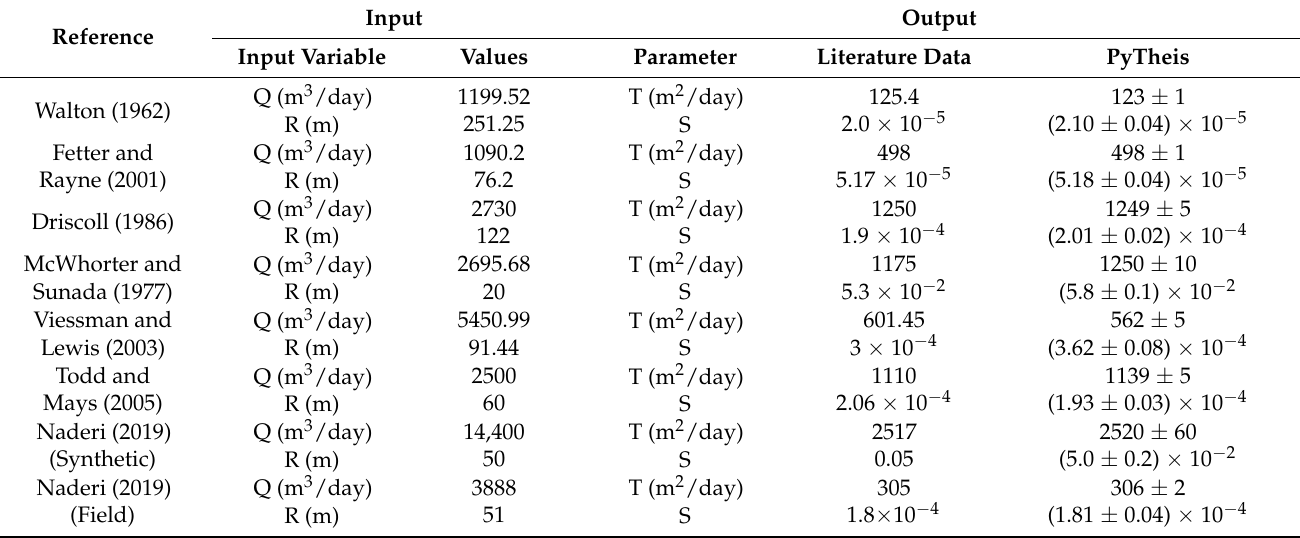
Figure 3. Log–log scale time ‐ drawdown curves fitted using the PyTheis code for the literature problems: ( a ) Walton (1962), ( b ) Fetter and Rayne (2001), ( c ) Driscoll (1986), ( d ) McWhorter and Sunada (1977), ( e ) Viessman and Lewis (2003), ( f ) Todd and Maya (2005), ( g ) Synthetic data from Naderi (2019), and ( h ) field data from Naderi (2019). The data points were taken from the tables/figures reported in these publications. Table 2. Details of the eight test problems used in this study. The table also provides the T and S values estimated by PyTheis along with literature